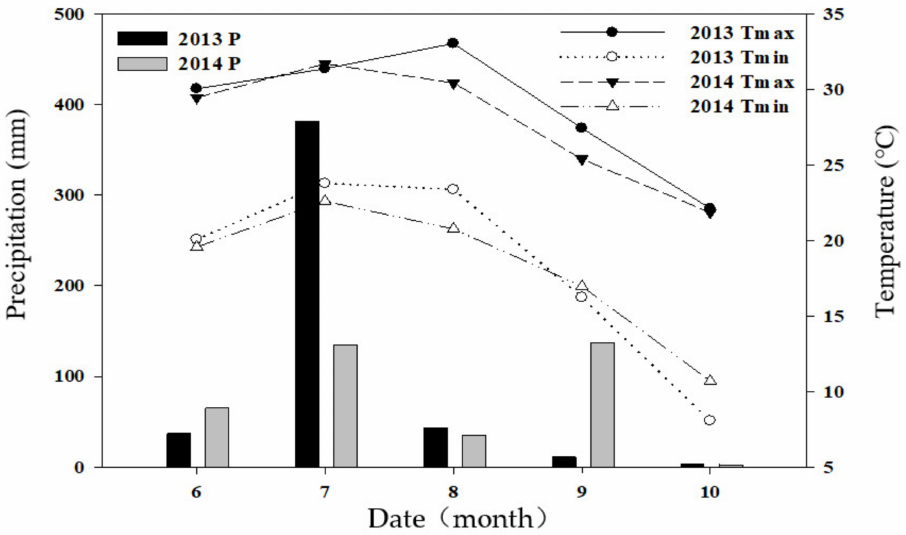
Figure 1. Rainfall and temperature during summer maize growth period from 2013 to